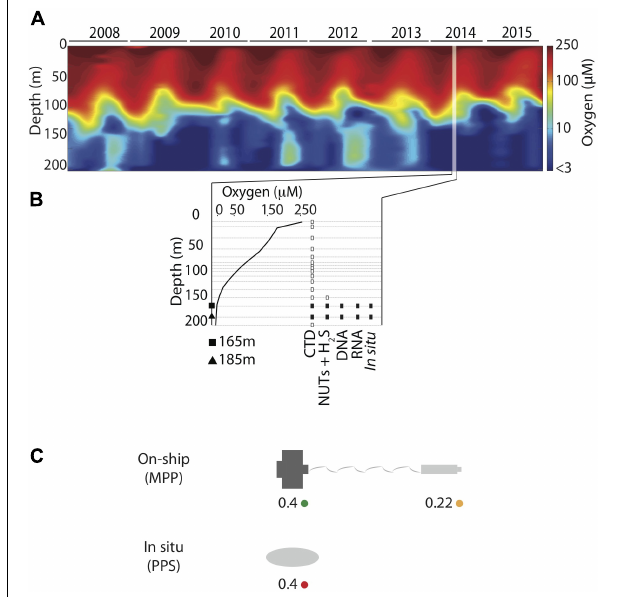
FIGURE 1 | (A) Saanich Inlet time-series CTD oxygen (O 2 ) concentration contour (2008–2015) showing seasonal water column stratification and deep-water renewal events. (B) Sample inventory for SCOR workshop held in July 2014 includes CTD, nutrients (NO 3 , NO 2 , NH 4 , PO 4 , and SiO 2 ), hydrogen sulfide (H 2 S), and multi-omic on-ship and in situ data. Data shown in this survey is depicted as solid symbols ( in situ and on ship DNA and RNA (rectangle) collected at 165 (square) and 185 (triangle) meters. (C) Schematic model for filter combinations and filtration methods showing on-ship [MasterFlex peristaltic pump (MPP)] filtration onto 0.4 µ m pre-filters (green), filtration onto 0.22 µ m filters with in-line pre-filtration using the 0.4 µ m pre-filters (yellow), and in situ filtration (PPS) onto 0.4 µ m filters without pre-filtration